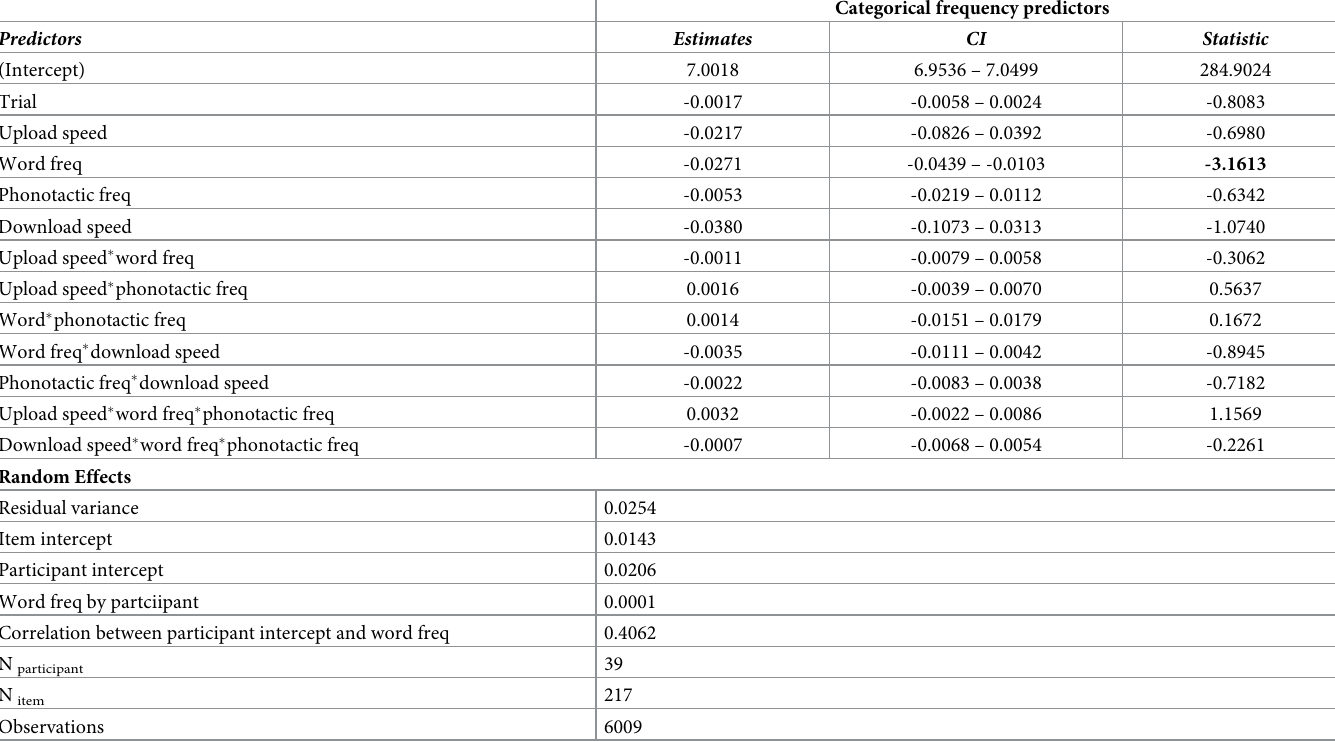
Table 3. Linear mixed model outputs of internet speed affecting latency, with categorical frequency